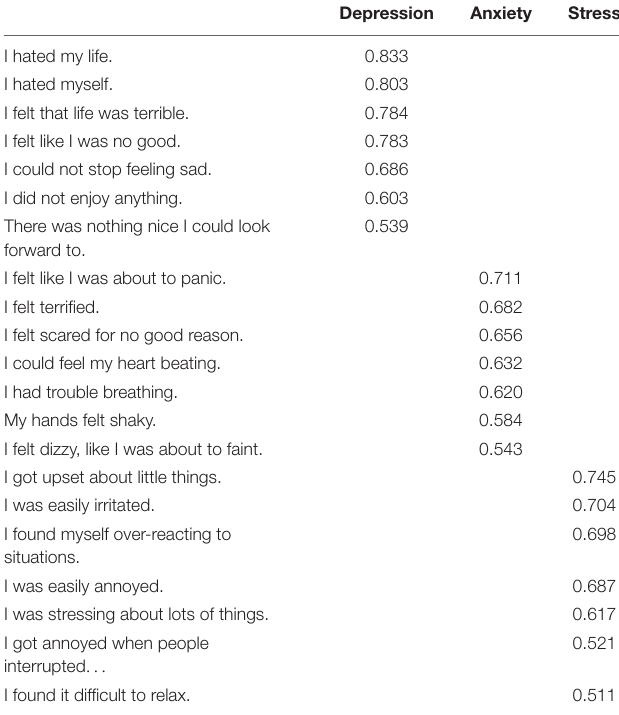
TABLE 5 | Factor loadings for the 21-item DASS-Y in the cross-validation sample ( N = 1046).